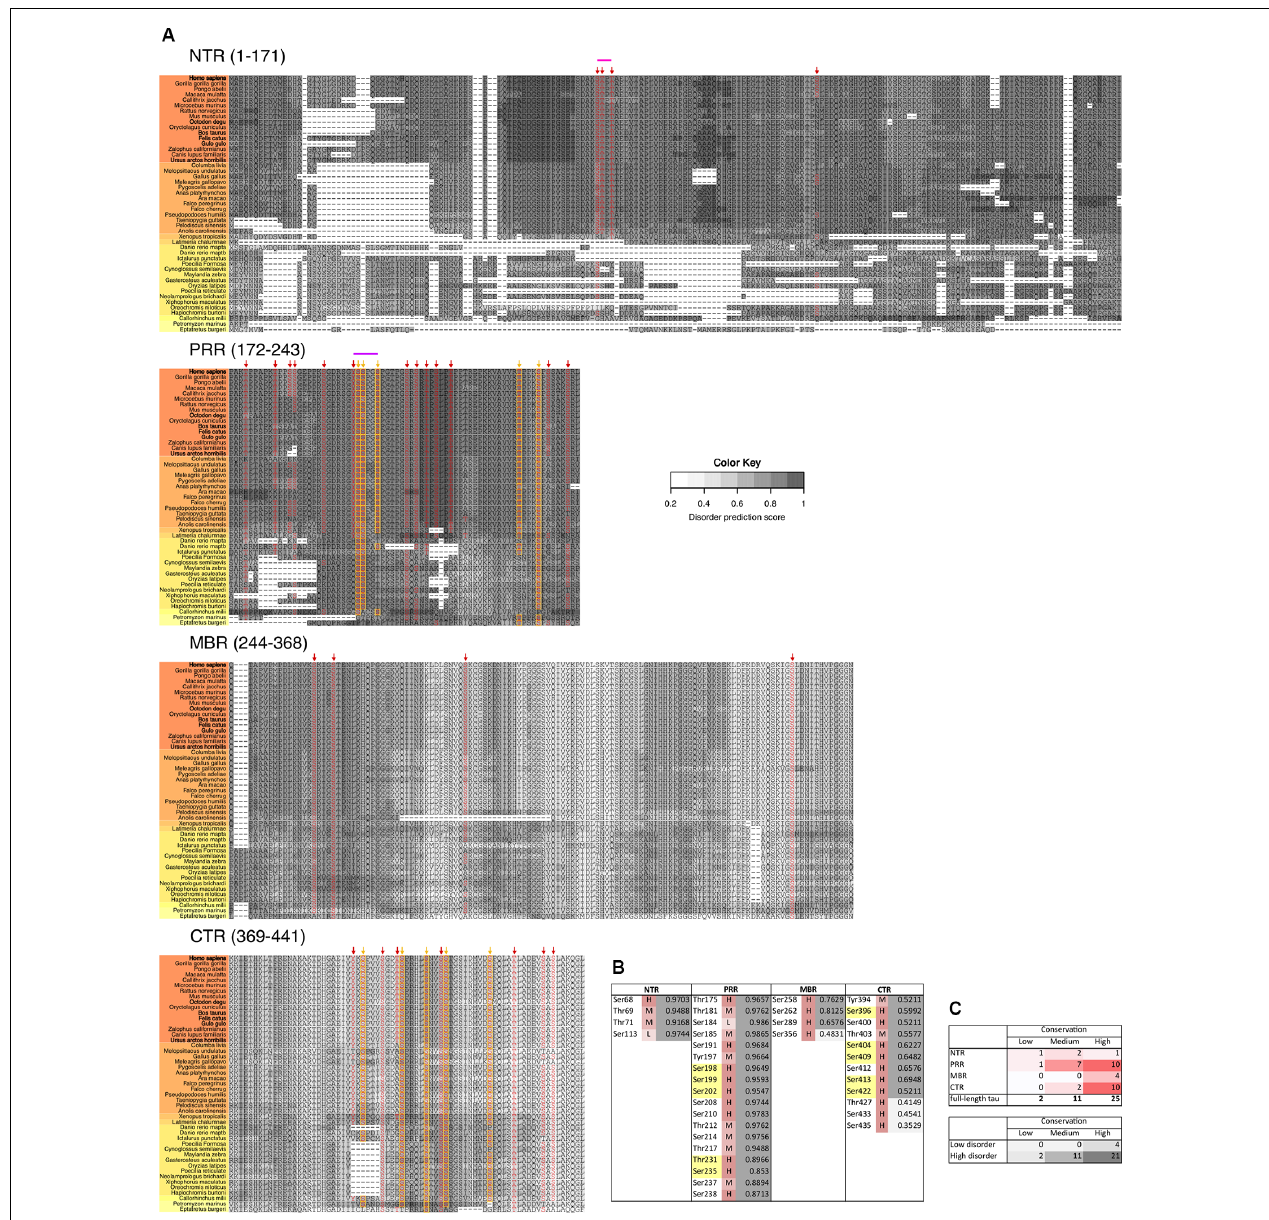
FIGURE 5 | Disease-associated tau hyperphosphorylation sites are highly conserved while many phosphosites in the NTR and PRR exhibit a lower degree of evolutionary conservation. (A) Comparison of tau sequences from 47 different species is shown. The selected organisms are grouped according to higher taxons (Cyclostomata, Actinopterygii, Coelacanthiformes, Amphibia, Sauropsida, Mammalia) and are color-coded from yellow (lower vertebrates) to orange (higher vertebrates). The extent of disorder (as predicted by IUPred2A) is indicated by the gray value according to the color key. The position of disease-associated phosphorylation sites as they have been shown in Figure 4 are indicated by red arrows, major phosphorylation sites by yellow arrows. The STPT site and the YSSPGS motif in the human sequence, which show an increase in the number of clustered phosphorylatable residues is shown by pink and violet lines, respectively. (B) Level of conservation of the disease-associated phosphorylation sites is shown (H: high conservation—present in > 66% of species; M: medium conservation—present in 33%–66% of species; L: low conservation—present < 33% of species). The extent of disorder (as predicted by IUPred2A) is also shown. Light gray indicates disorder < 0.5, dark gray > 0.5. (C) Summary representation of the level of conservation of the phosphorylation sites with respect to the region of tau (top), and the extent of disorder (bottom).